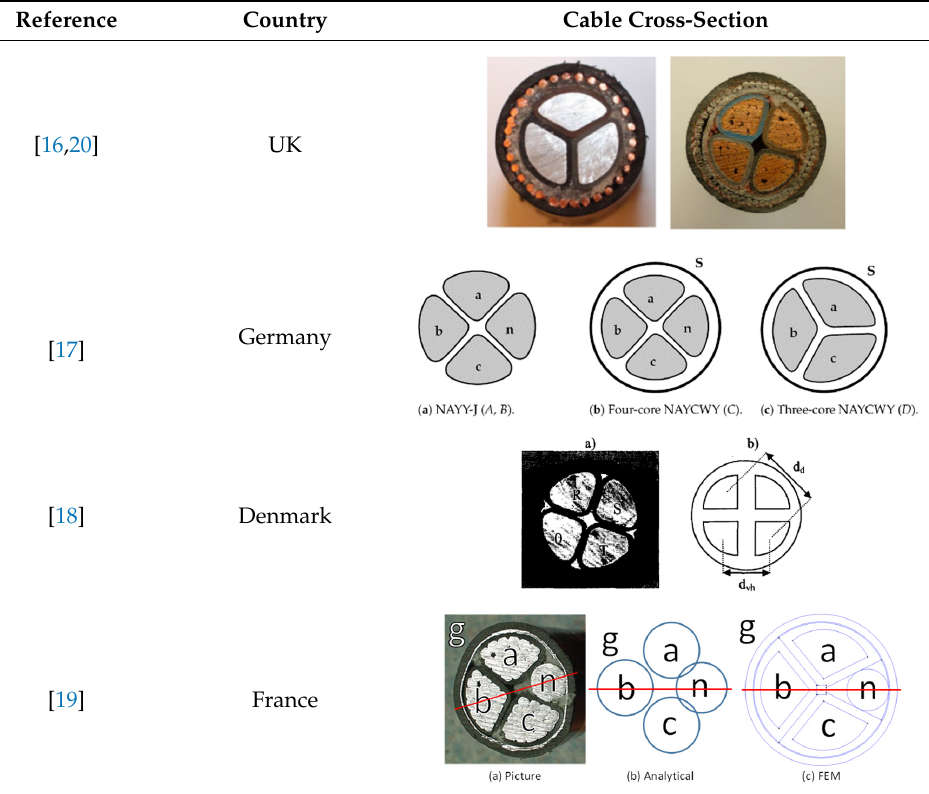
Table 1. Cross-section of European LV cables.